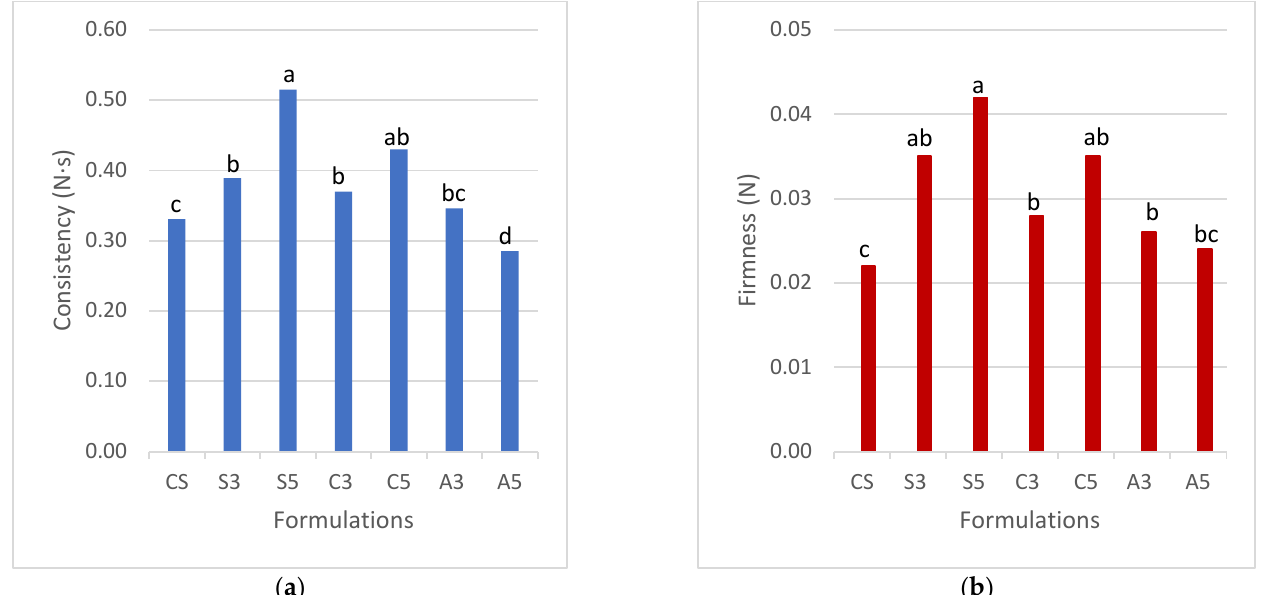
Figure 3. Force of extrusion measurements for different proteins at different concentrations. a) Consistency b) Firmness Note: CS (Control Sample), S3 (3% Soy), S5 (5% Soy), C3 (3% Cricket), C5 (5% Cricket), A3 (3% Albumin), and A5 (5% Albumin). Different superscript letters indicate a significant